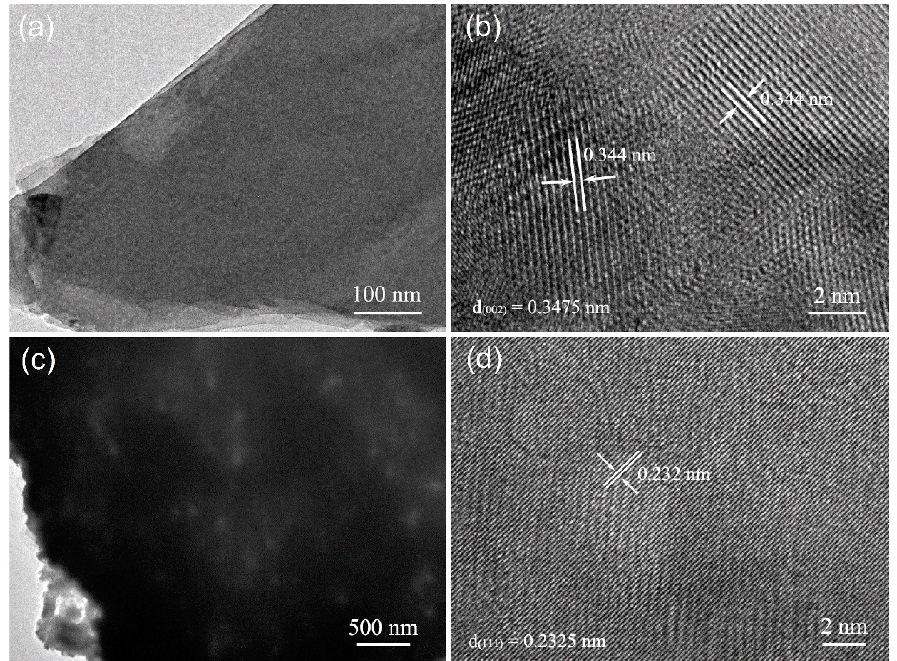
Figure 6. ( a ) The TEM and ( b ) HRTEM images of the as-grown Cu 2 (NO 3 )(OH) 3 fabricated with 50 mM Cu 2+ ion concentration and 20 min UV illumination time. ( c ) The TEM and ( d ) HRTEM images of the CuO annealed at 300